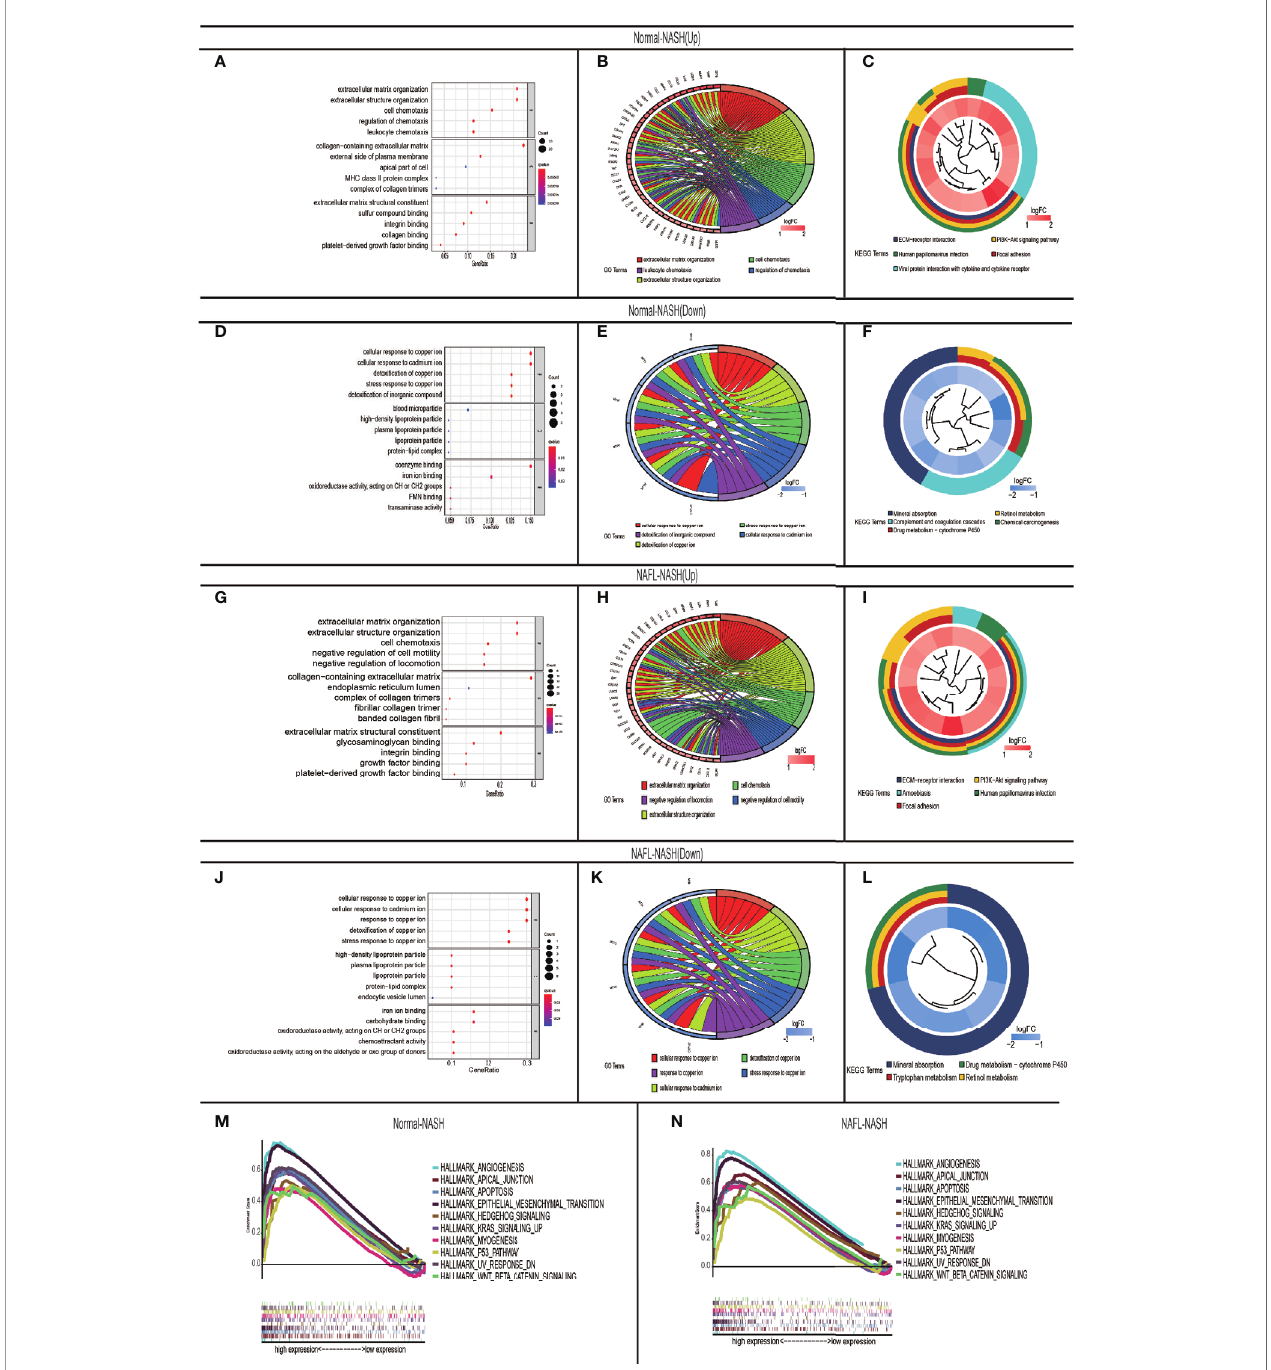
FIGURE 3 | GO\KEGG and GASE in non-alcoholic fatty liver disease. (A – C) Up-regulated Normal-NASH group. GO analysis (including molecular function (MF), biological process (BP), and cell component (CC) (A) ; Top 5 of GO analysis (B) ; KEGG pathway analysis (C) ; (D – F) Down-regulated Normal-NASH group. GO analysis (including molecular function (MF), biological process (BP), and cell component (CC) (D) ; Top 5 of GO analysis (E) ; KEGG pathway analysis (F) ; (G-I) Up- regulated NAFL-NASH group. GO analysis (including molecular function (MF), biological process (BP), and cell component (CC) (G) ; Top 5 of GO analysis (H) ; KEGG pathway analysis (I) ; (J – L) Up-regulated NAFL-NASH group. (GO analysis (including molecular function (MF), biological process (BP), and cell component (CC) (J) ; Top 5 of GO analysis (K) ; KEGG pathway analysis (L) ; (M, N) Top 10 interactive pathway of GASE in Normal-NASH group (M) /NAFL-NASH group (N) (GSE33814 and